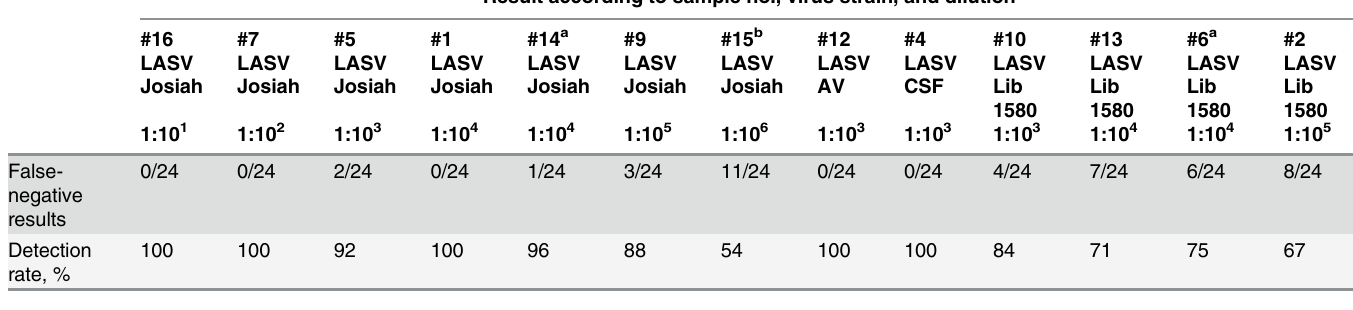
Result according to sample no., virus strain, and